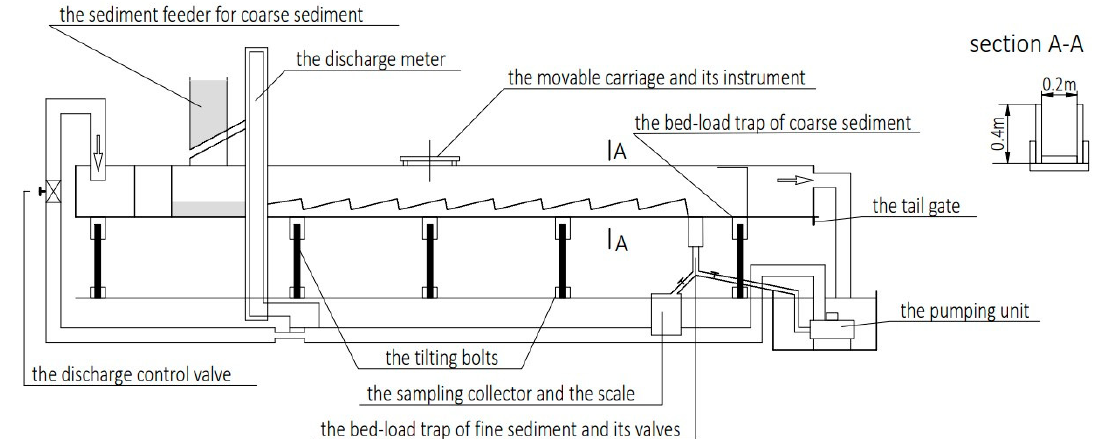
Figure 6. Experimental setup for steady flow measurements by Elhakeem and Imran (2012) [54].